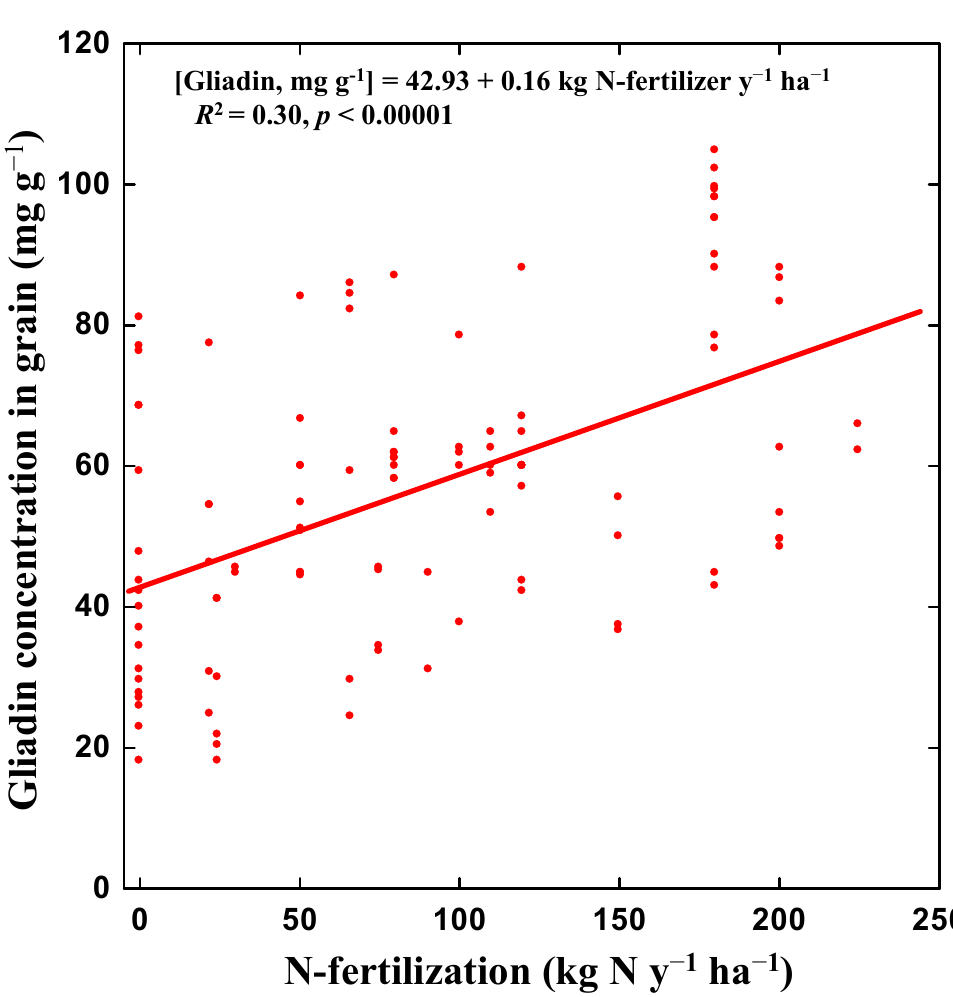
Figure 3. Increases in total gliadin contents in wheat grains as a function of the increases in N-fertilisation rates (kg N ha − 1 y − 1 ). See Table 1 for the sources. The per capita annual increase in gliadin intake from wheat and derived foods during 1961–2010 was estimated to be approximately 1.4 kg y − 1 (+58% ± 7.5%) (Mean ± SE; Figure 4). This estimation took into account the annual intake of wheat and derivatives at the global scale, [3] the increase in N fertilisation in wheat crops and the relationships between N fertilisation and gliadin increase (Figure 3 and Table 1). The increase in N-fertilisation from approximate 10 to 100 kg N ha − 1 corresponded to an increase in gliadin contents in grains/flour from 44 to 59 mg g − 1 , respectively) (Figure 3 and Table 1).